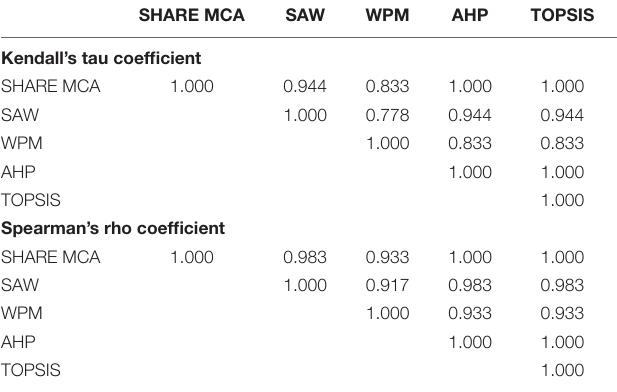
TABLE 5 | Numerical results of Kendall’s tau and Spearman’s rho correlation tests between the compared methods (excluding VIKOR and ELECTRE III), with the first scheme of weights.